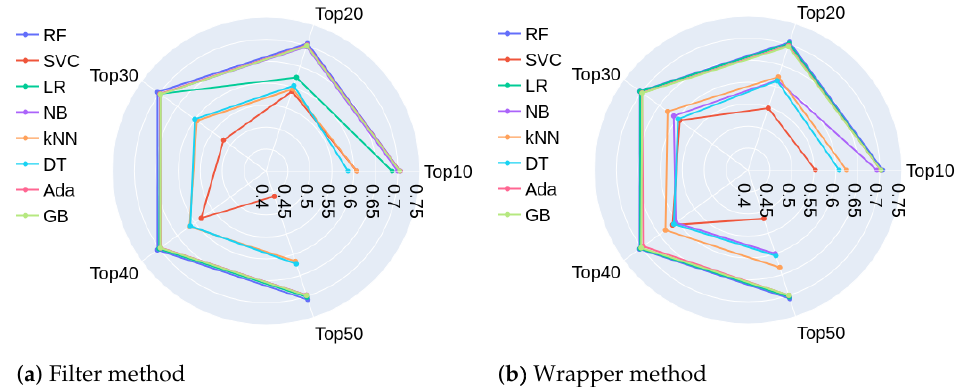
Figure 9. Accuracy of classifiers with selected features for power system dataset Figure 8. Accuracy of classifiers with selected features for power system